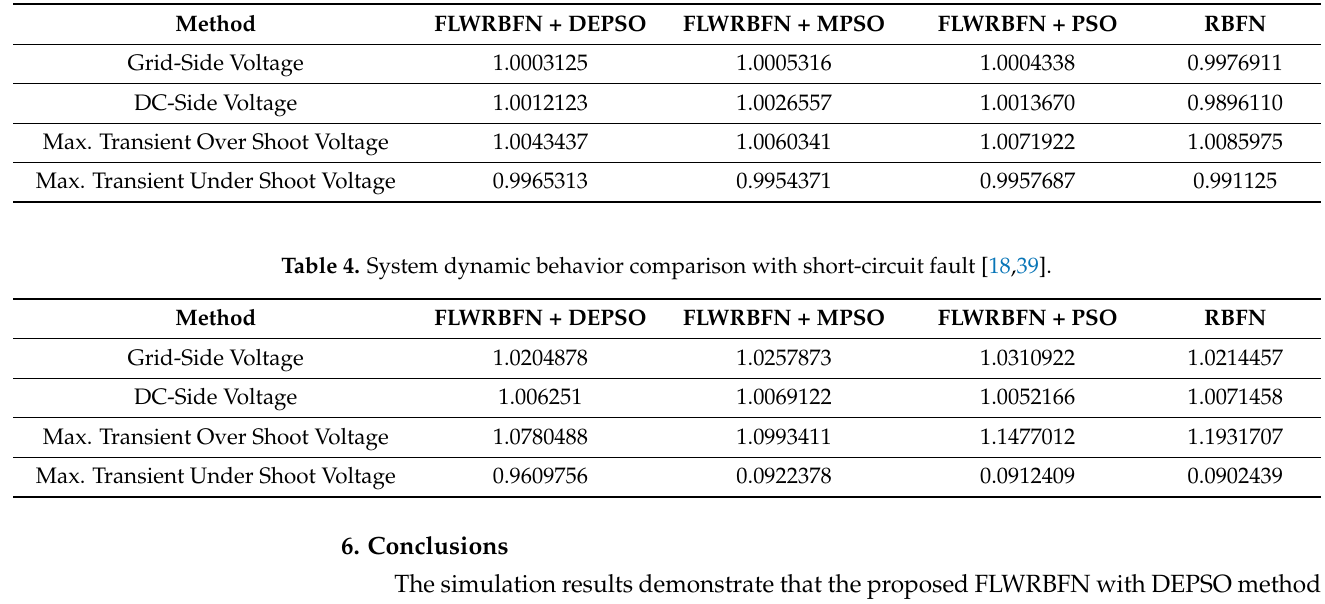
Table 3. System dynamic behavior comparison with load change [18,39].